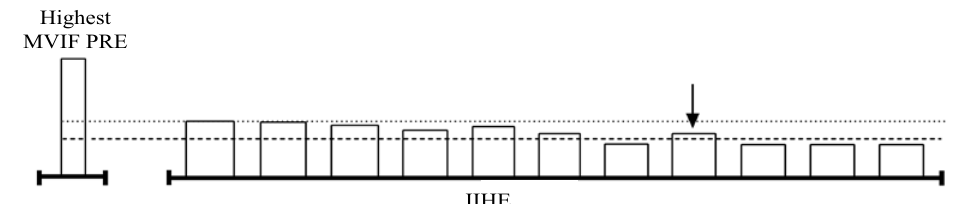
Figure 1. A timeline describing the experimental procedures. The superior line indicates the target force (45% of maximal voluntary isometric force [MVIF]). The inferior line indicates the cutoff force to consider task failure (i.e., the minimum force [30% of MVIF]). The black arrow indicates the last valid contraction, since the inability to sustain the force above the cutoff (30% of MVIF) for three consecutive contractions was established as the criteria for task failure. IIHE: Intermittent isometric handgrip exercise.